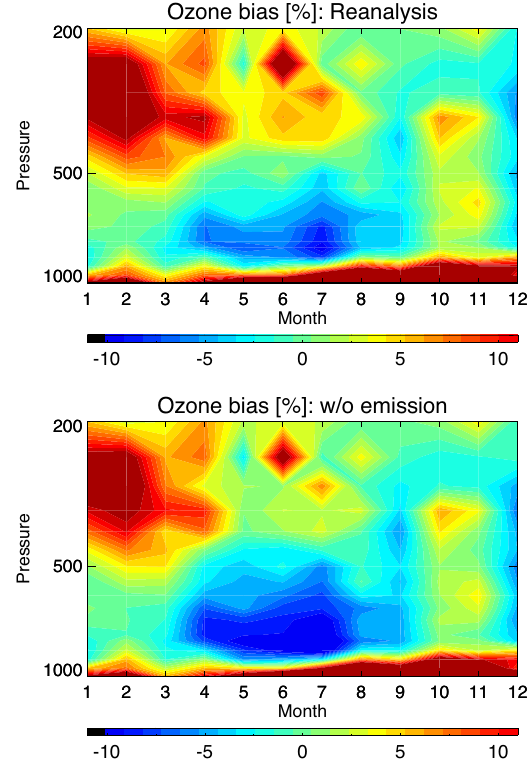
Figure 17. Month–pressure cross section of the zonal mean bias of O 3 concentration (in %) compared with the ozonesonde obser- vations averaged over 30–60 ◦ for the reanalysis run (top) and the sensitivity experiment that excludes the emission factors from the state vector (w/o emission,